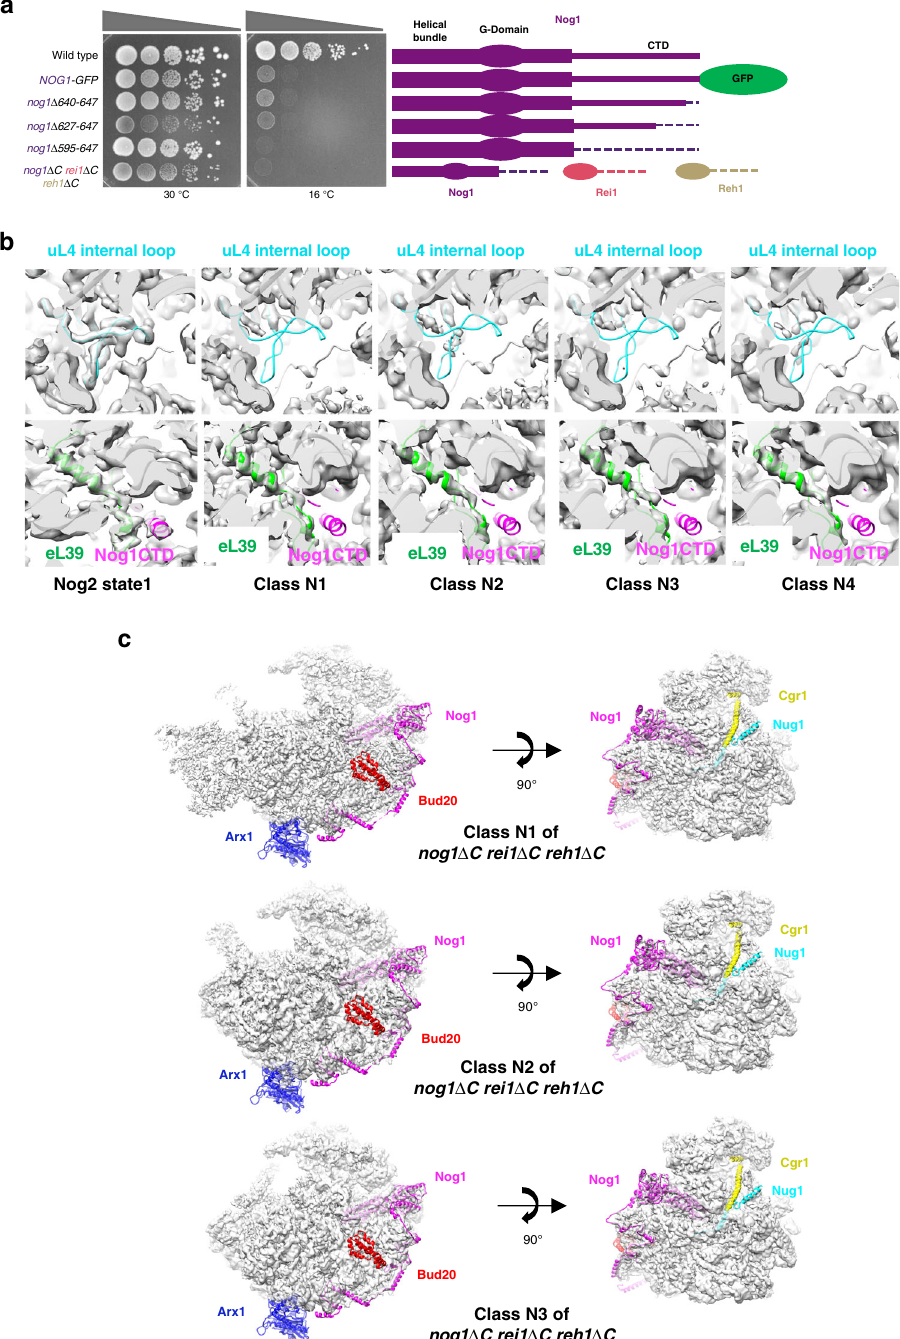
Fig. 5 The Nog1 CTD stabilizes the tunnel domain of uL4. a Serial dilutions (1:10 to 1:10,000) of NOG1 wild-type and nog1 mutant cultures were spotted onto solid medium containing glucose, and incubated at 30 °C or 16 °C, for 8 days. Each construct is depicted in cartoon form (right). b Density maps of the wild-type Nog2 state 1 and N1 – N4 mutant particles are aligned with the atomic model of wild-type Nog2 state 1 particles, displaying the interior of the NPET. Densities (gray) for the uL4 TD (cyan) are missing in the NPET in all four mutant classes (top). Densities for eL39 (green) can be visualized in classes N1 – N4 but no densities for the Nog1 CTD (magenta) are visible (bottom). c View of nog1 Δ C rei1 Δ C reh1 Δ C classes N1 – N3 from the subunit interface. Densities are fi tted to the atomic model of wild-type Nog2 state 1 (PDB: 3jct). Exposed cartoon models of Arx1 (blue), the Nog1 CTD (magenta), Bud20 (red), Cgr1 (yellow), and Nug1 (cyan) represent missing densities for each respective